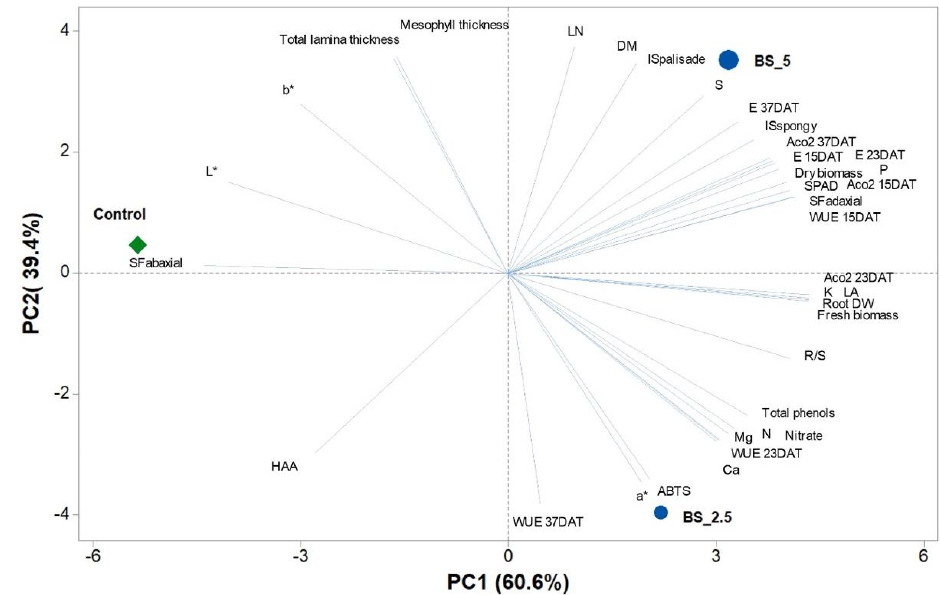
Figure 4. The principal component loading plot and scores of principal component analysis (PCA) of biometric traits, leaf colorimetric parameters, mineral nutrients, gas exchanges, bioactive compounds, and antioxidant activity in lettuce under three PH dose treatments (0.0, 2.5 and, 5.0 mL L – 1 ).